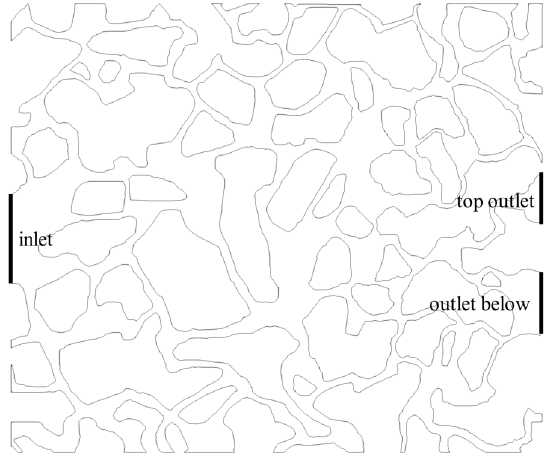
Figure 1. Porous structure used in the